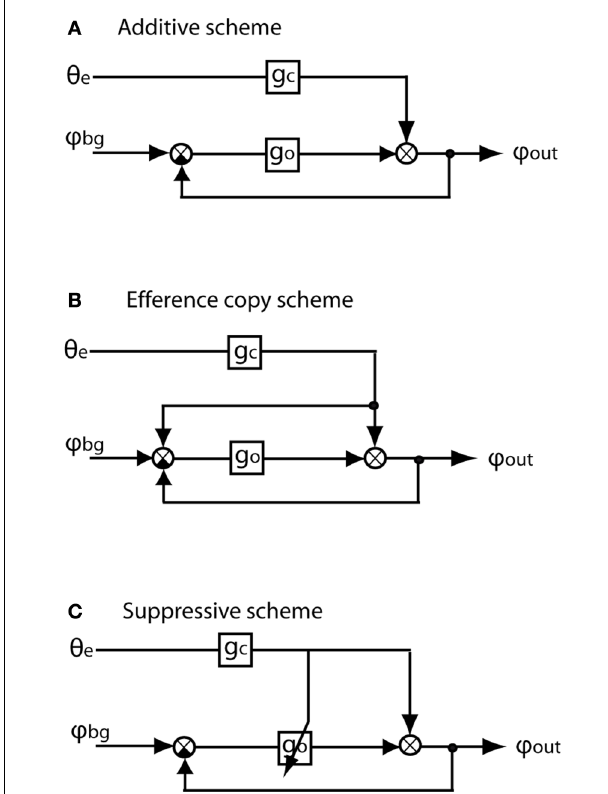
FIGURE 1 | Flow diagrams of three possible forms of interaction between the chasing system and the optomotor following system. The input to the chasing system is θ , i.e. the error angle of the target relative to the frontal e and g are the internal gains of the chasing midline of the fl y’s visual fi eld. g c o system and the optomotor system, respectively. The input to the optomotor system is provided by ϕ , i.e. the angular velocity of the environment (i.e. bg background). ϕ is the fi nal turning response of the animal which is the sum of out the turning responses mediated by the optomotor system and the chasing system. (A) Additive scheme: The signals mediating the turning responses of the chasing and the optomotor system are just added. There are no other interactions within the nervous system between the two system. (B) Efference copy scheme: As the additive scheme; however a copy of the turning command (‘efference copy’) is added to the input signal of the optomotor system to cancel during chasing behavior the visual feedback resulting from turns evoked by the optomotor system. (C) Suppressive scheme: A copy of the chasing control signal does not interact with the optomotor input signal in a linear way, as does the efference copy scheme, but reduces the internal optomotor gain or even suppresses the optomotor signal completely. Gain control has the advantage that the copy of the chasing signal does not need to be exactly adjusted to the visual feedback which cannot easily be predicted under natural fl ight conditions ( A,B modifi ed from Collett,